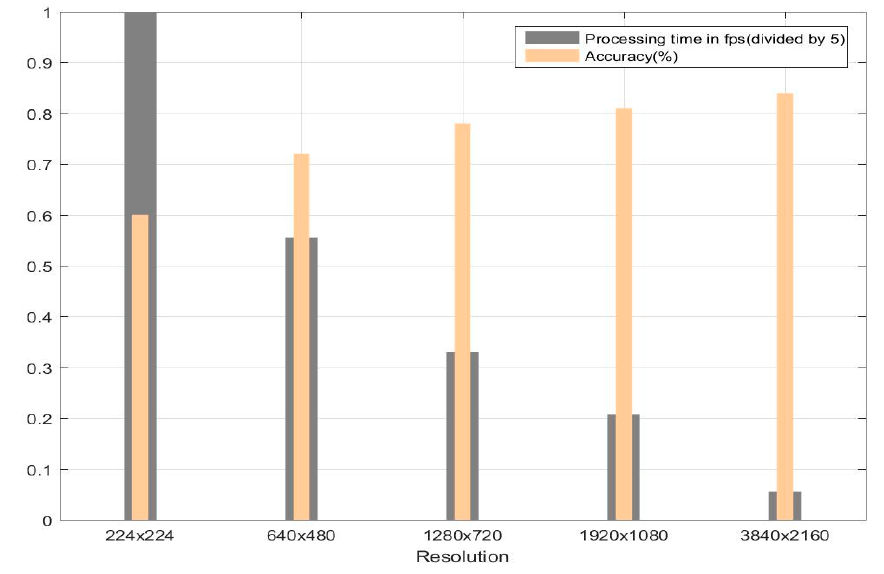
Figure 13. Bar graph showing the change in accuracy and detection rate as resolution increases.